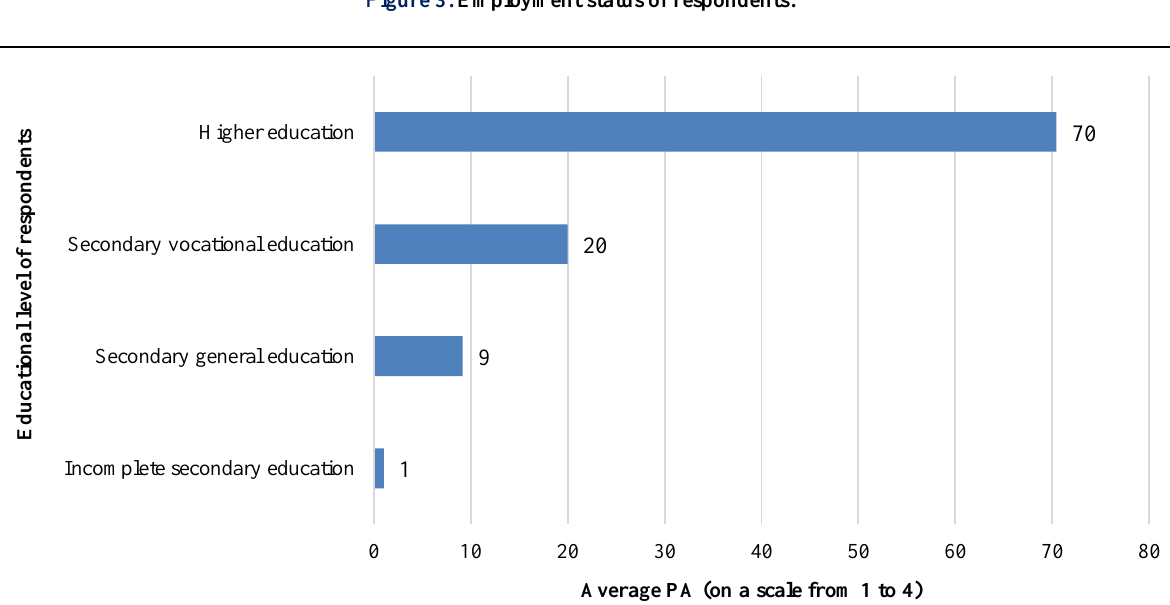
Figure 3. Employment status of respondents.